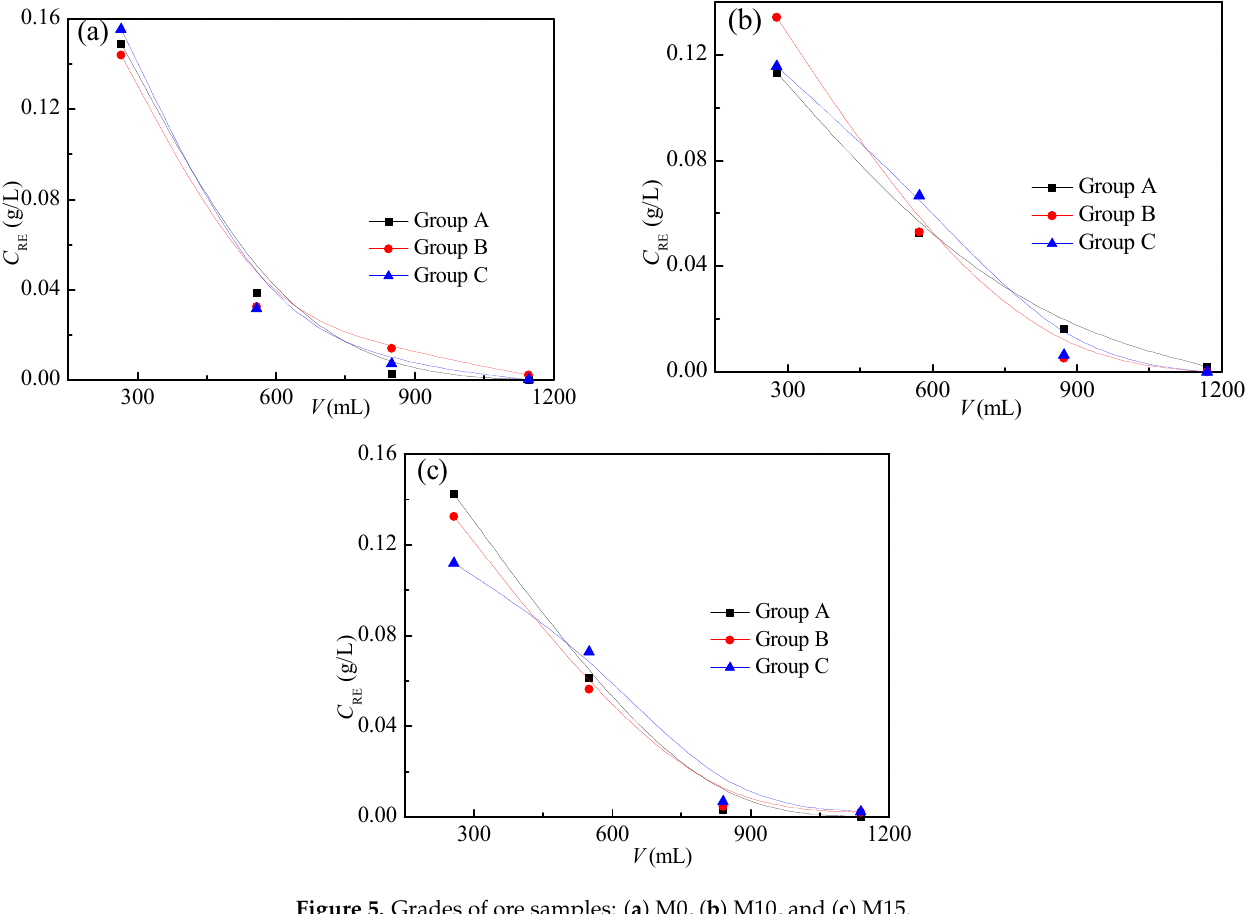
Figure 5. Grades of ore samples: ( a ) M0, ( b ) M10, and ( c ) M15.